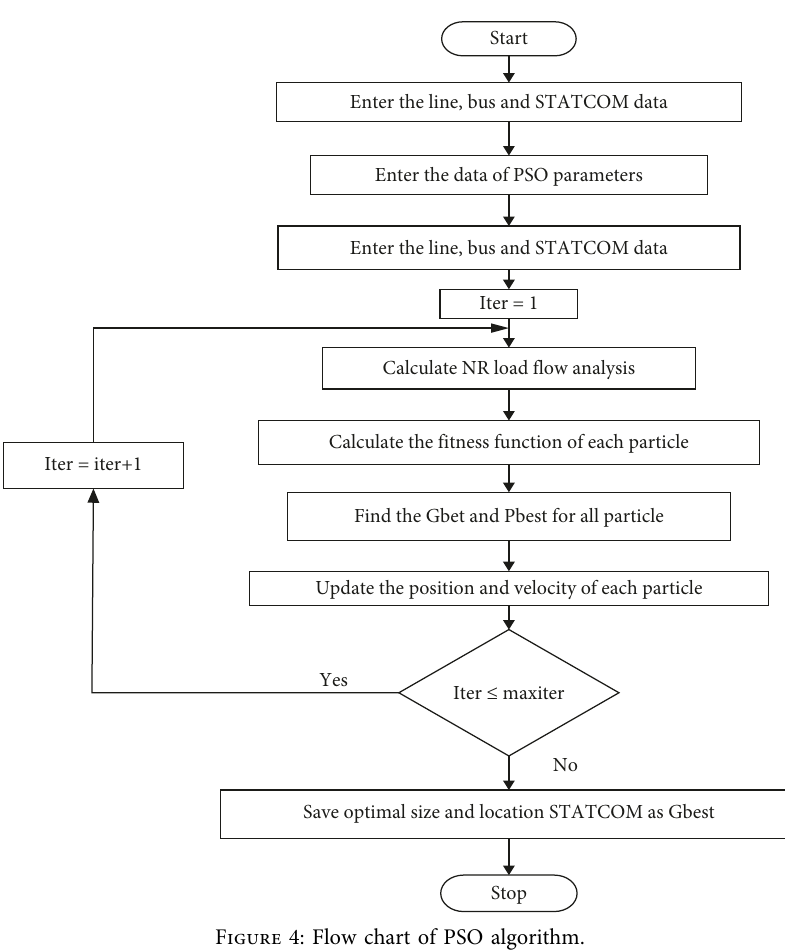
Figure 4: Flow chart of PSO algorithm.